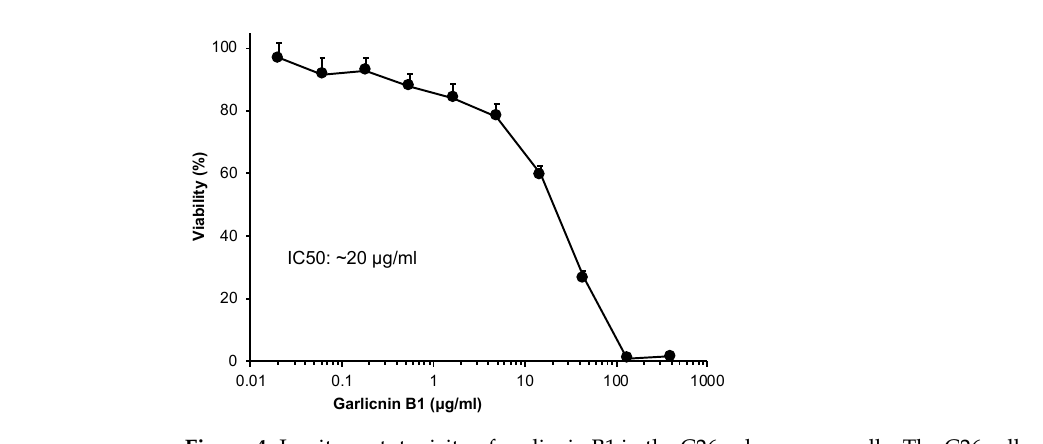
Figure 4. In vitro cytotoxicity of garlicnin B1 in the C26 colon cancer cells. The C26 cells were exposed to increasing concentrations of garlicnin B1 for 24 h, and cell viability was then determined by the MTT assay. Data are presented as means ± standard deviation (SD); n = 8. See text for details.